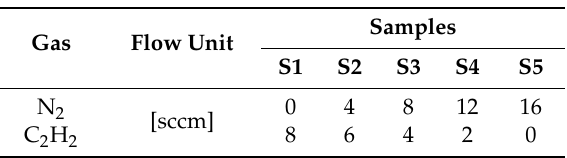
Table 2. Reactive gas flow.